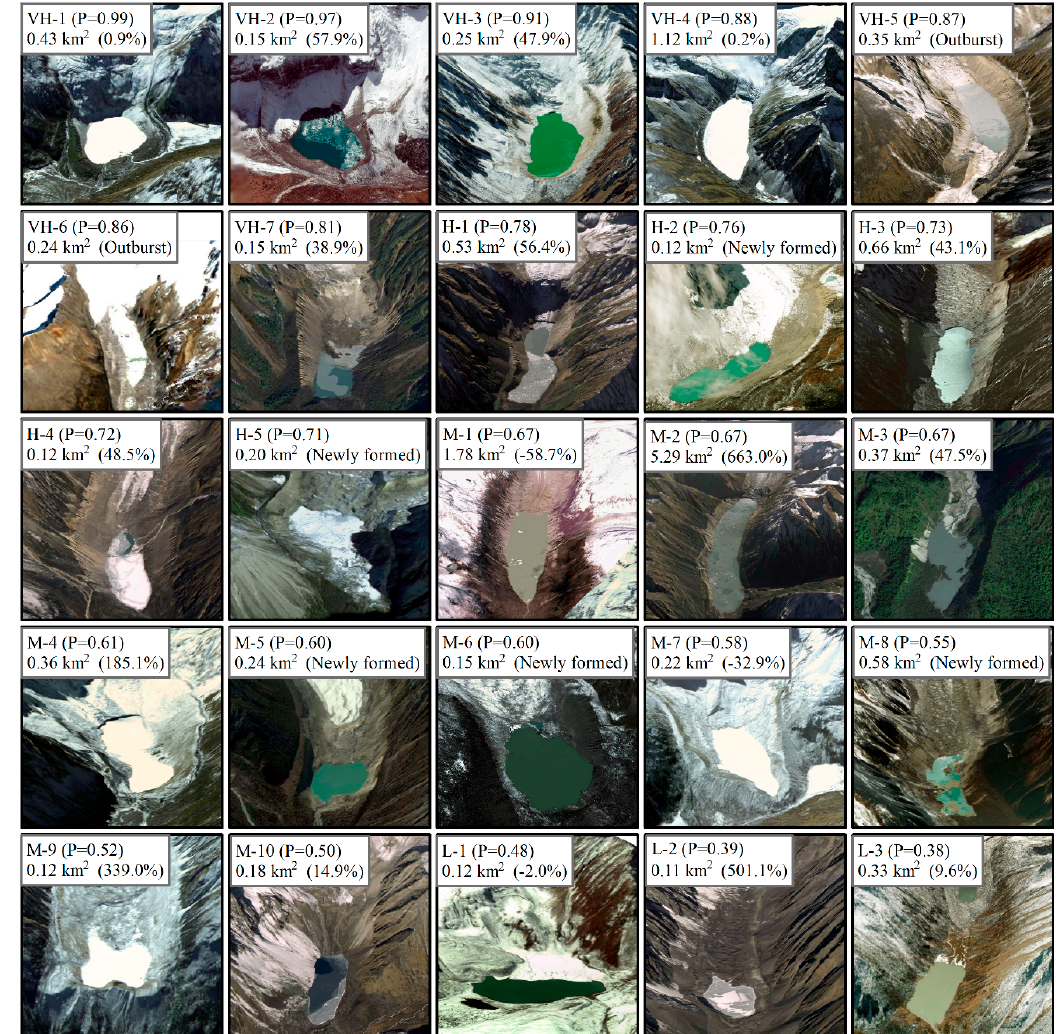
Figure 11. Illustration of glacial lakes with areas of larger than 0.1 km 2 in four outburst potential groups (VH represents lakes very high outburst potential; H represents lakes with high outburst potential; M represents lakes with medium outburst potential; L represents lakes with low outburst potential. These figures were taken from Google Earth Images and Map World Images.)